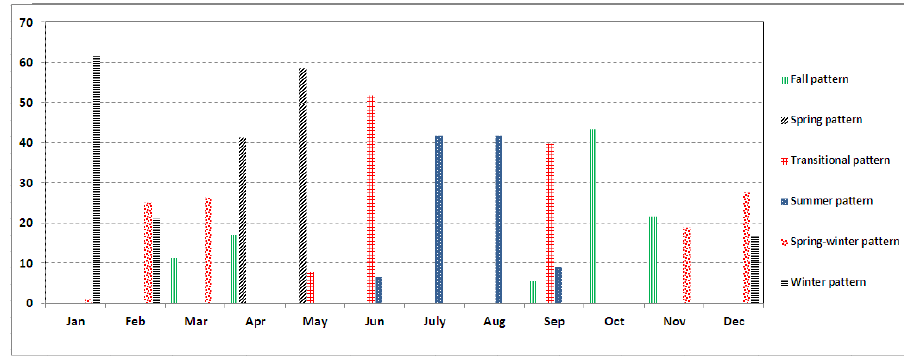
Fig. 3. Occurrence Percentage of Circulation Patterns in During